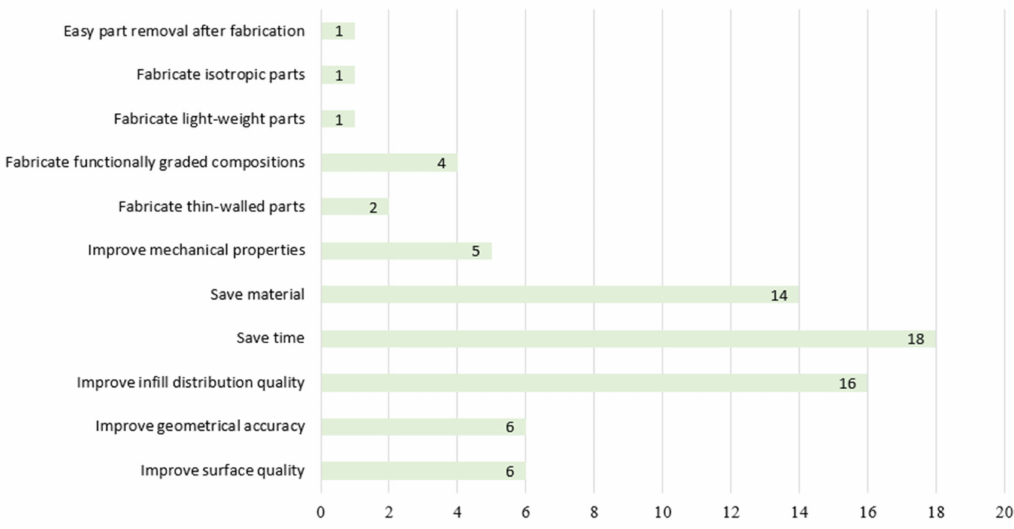
Figure 9. Number of publications with di ff erent